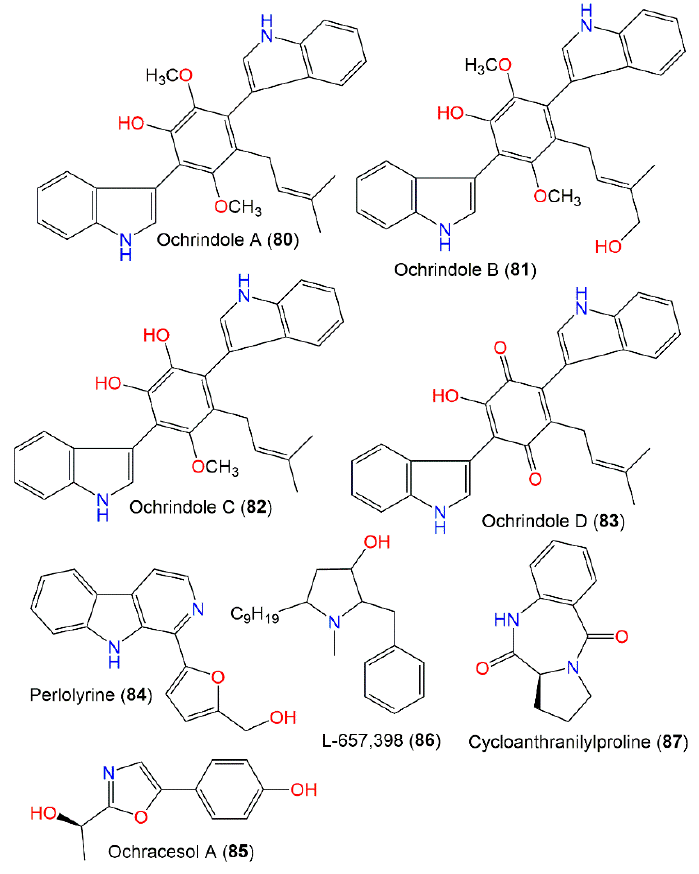
Figure 8. Indole and other alkaloids ( 80 – 87 ) reported from A. ochraceus.